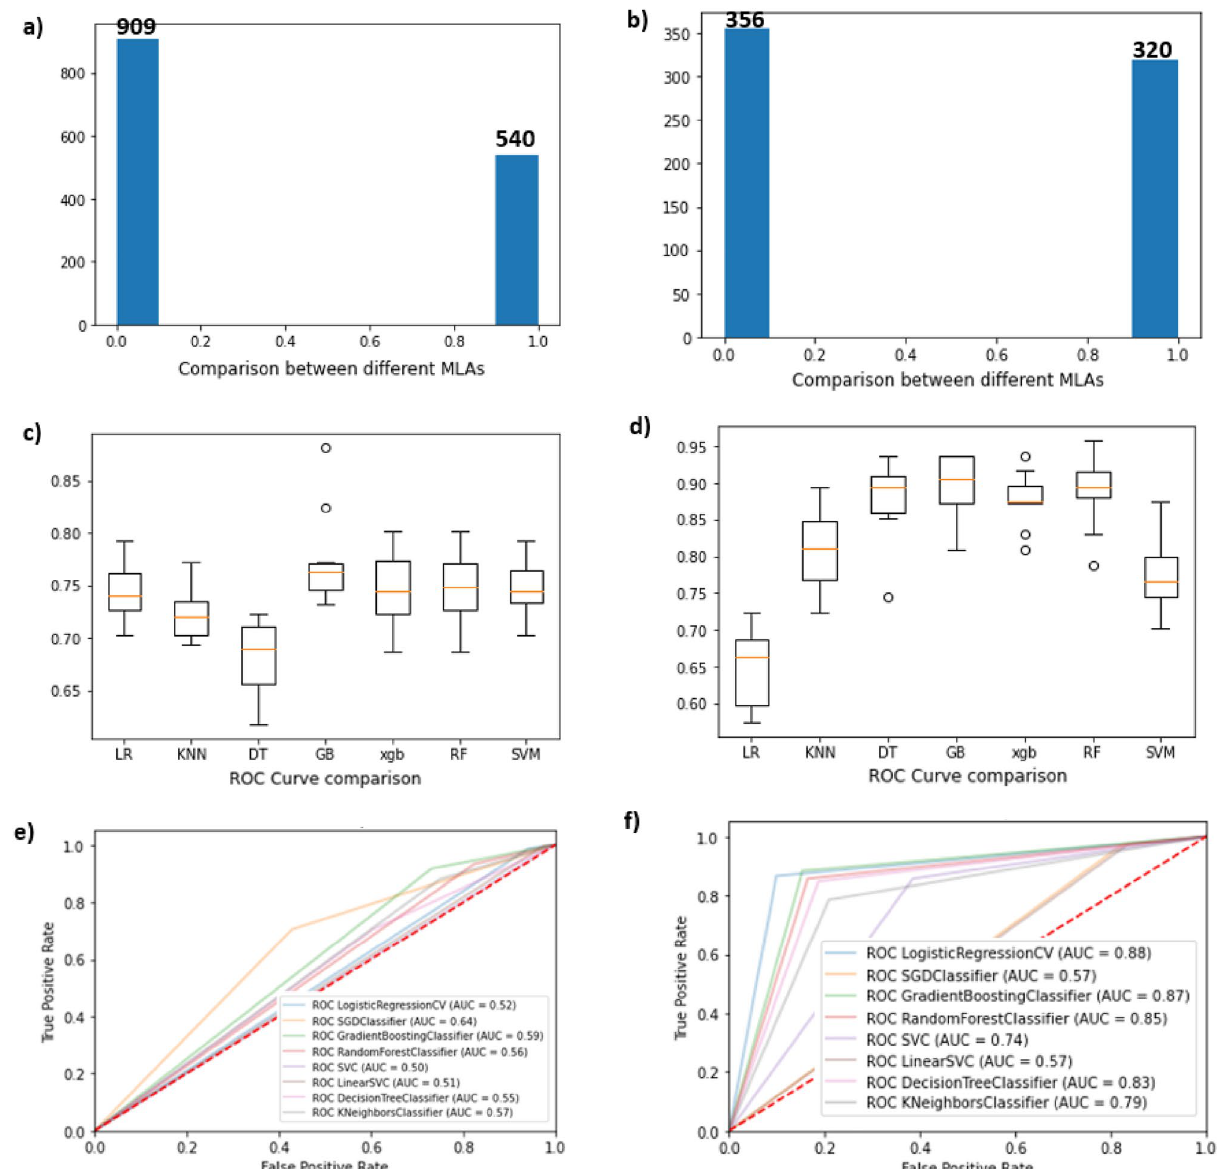
Figure 6. Comparative result analysis of various methods for the identification of the best machine learning models before and after the removal of outliers in the dataset ( a and b ) describes the number of clusters k representing the matching score of variables ( c and d ) A comparative analysis of various machine learning models and ( e and f ) Comparative analysis of